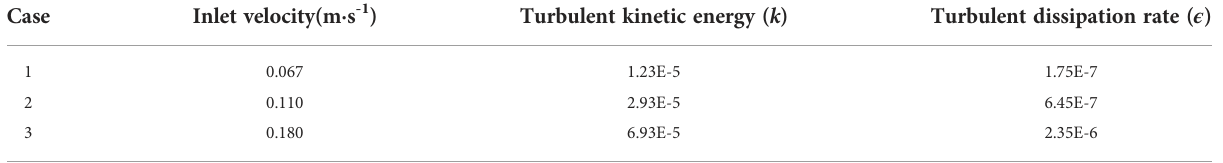
TABLE 2 Variable settings at the inlet.